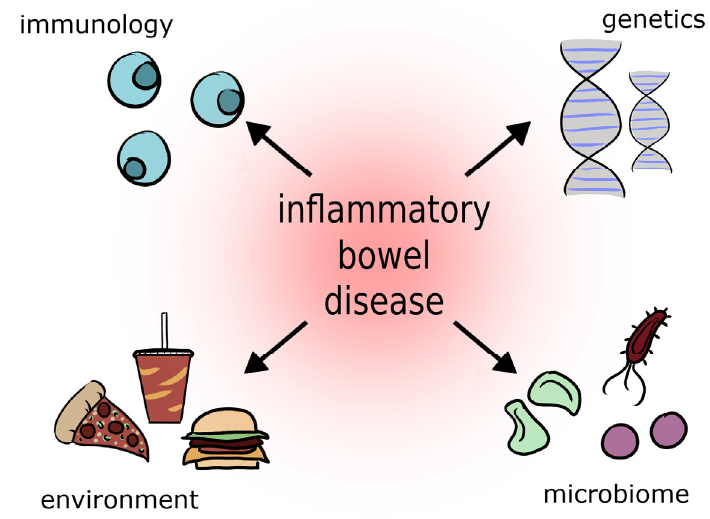
Figure 1. Etiology of Inflammatory Bowel Disease [27,31]. Table 1. Intestinal homeostasis disturbances in patients with inflammatory bowel disease